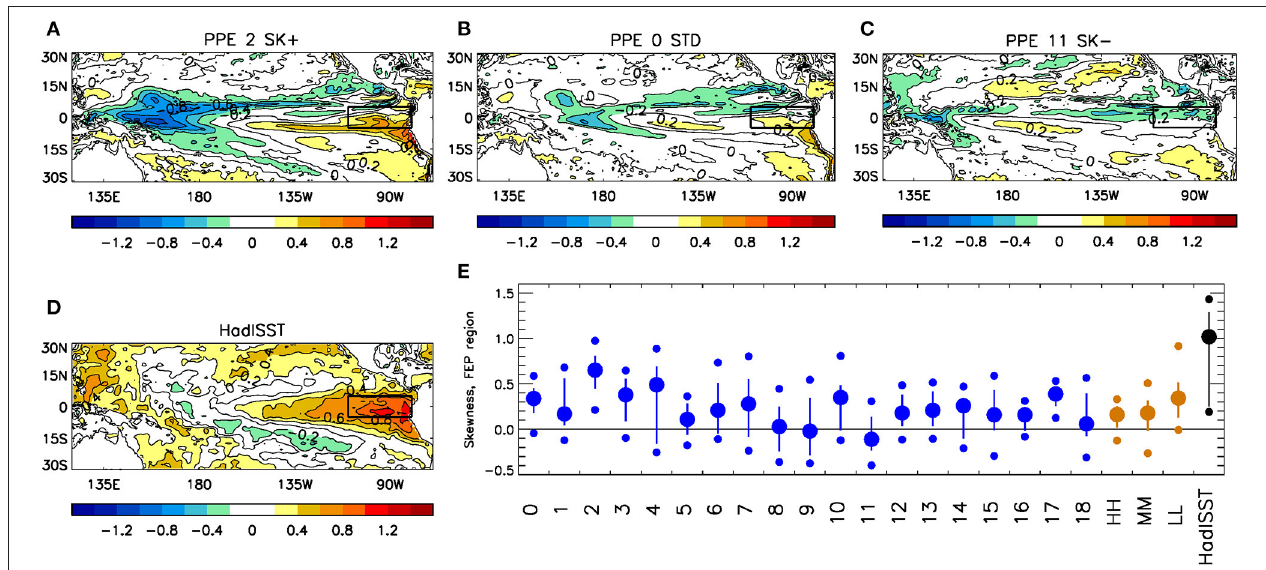
FIGURE 1 | Comparison of skewness in Met Office Hadley Centre models. Skewness in 3 PPE members (A–C) and observations (HadISST, 1873-2020) (D) . Rectangular box shows skewness in the far eastern Pacific region (FEP, 110-80 ◦ W, 5 ◦ N-5 ◦ S). Skewness in FEP for PPE members (blue), high, medium, and low resolution HadGEM-CG3.1 simulations (brown), and observations (black) (E) . Large circles show skewness over the full period of each model simulation, vertical bars show the 16th and 84th percentiles (corresponding to 1 standard deviation from the mean) and small circles are the maximum and minimum of skewness for 50-year sliding